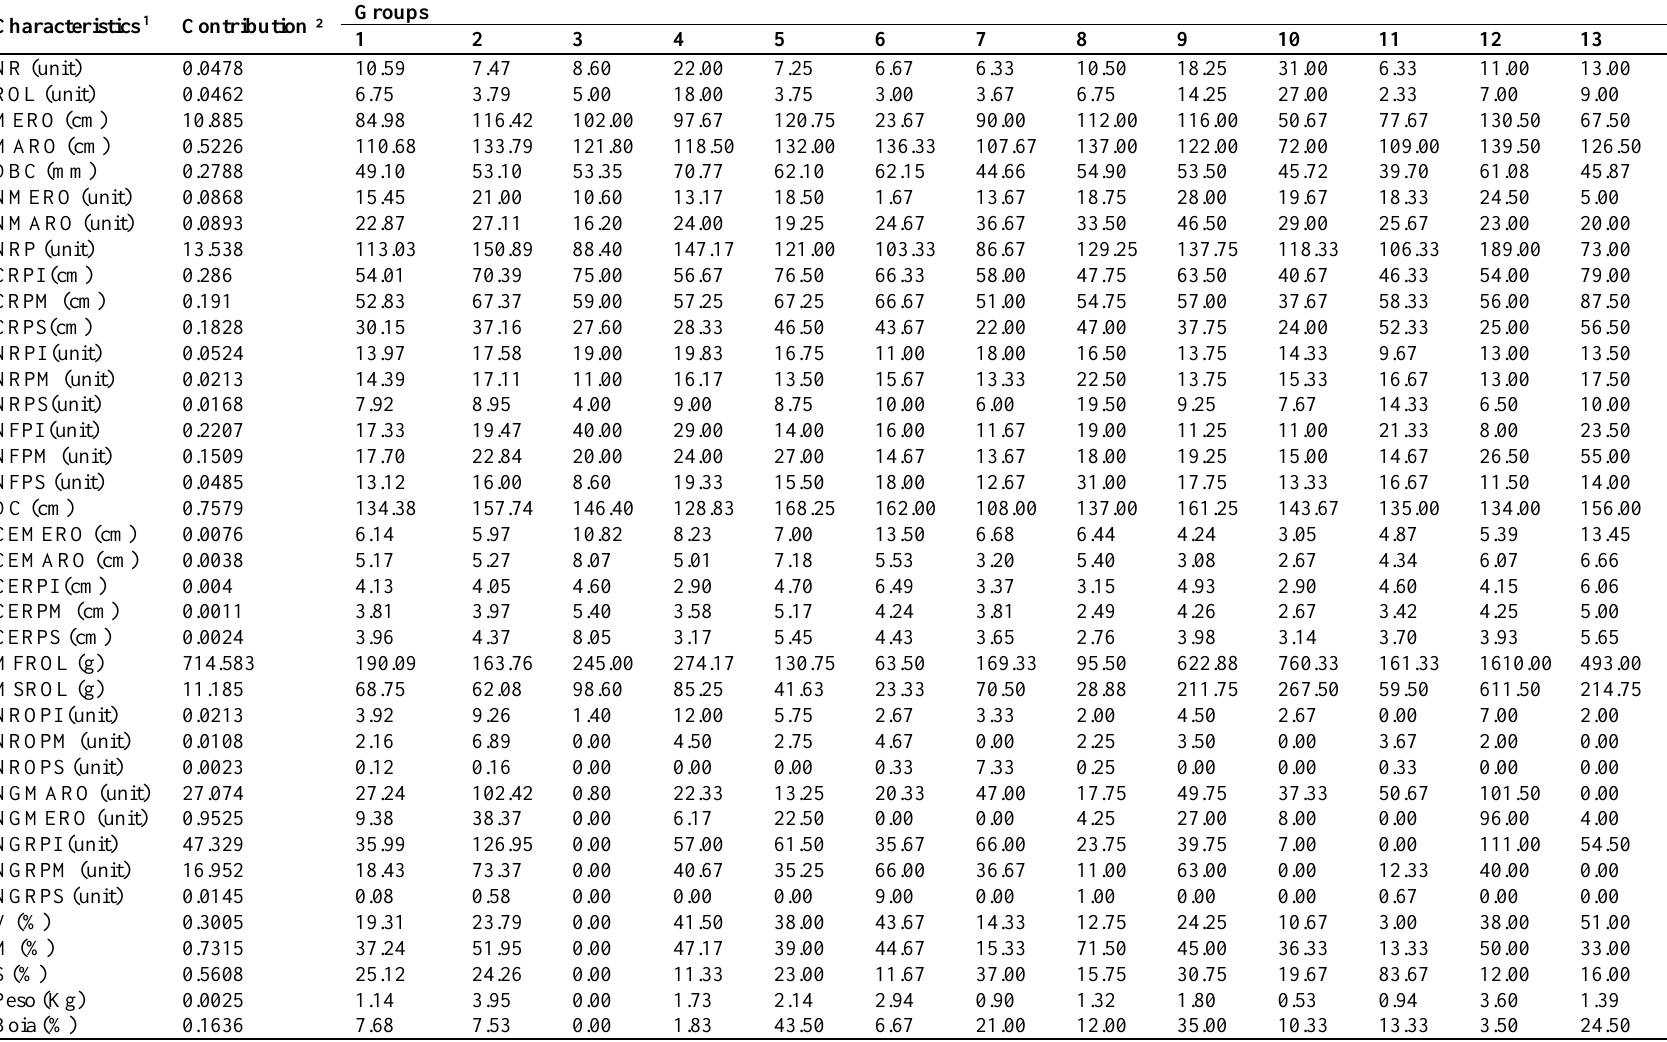
Table 3. The relative contribution of the 38 characters to the analysis of phenotypic variability and averages of the 25 groups obtained in the Tocher grouping, referring to the 323 accessions assessed by the Germoplasm Active Bank at the Experimental Farm of Bananal do Norte, Incaper, Cachoeiro do Itapemirim, Espírito Santo,